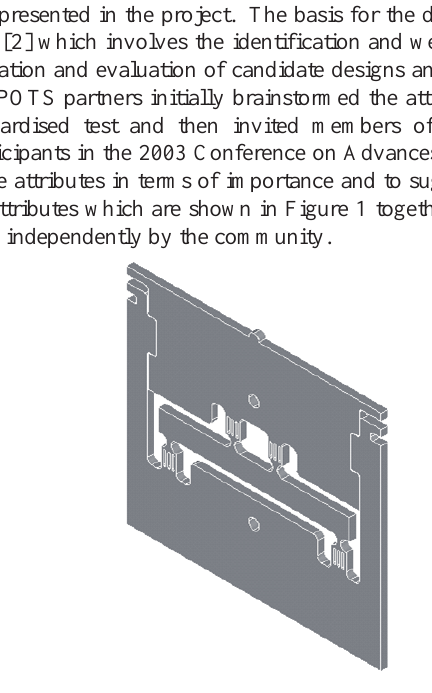
Fig. 2. Three-dimensional view of the physical reference material ( EU Community Design Registration 000213467 ) which is scalable to any size and can be manufactured in any material. (©SPOTS